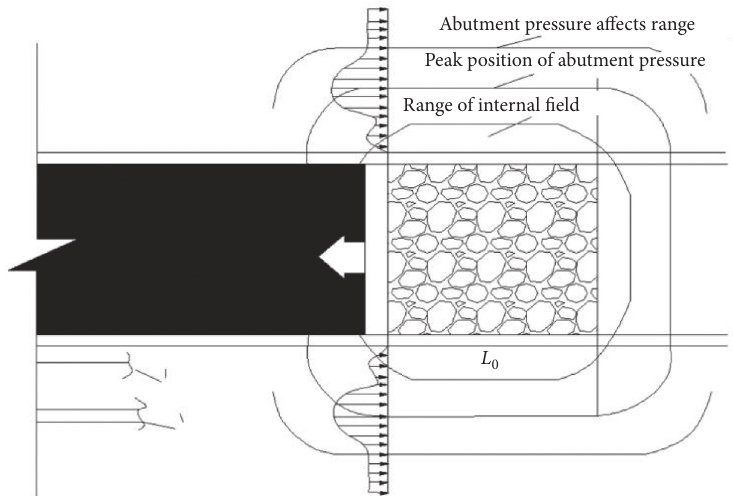
Figure 10: Schematic diagram of mining stress.